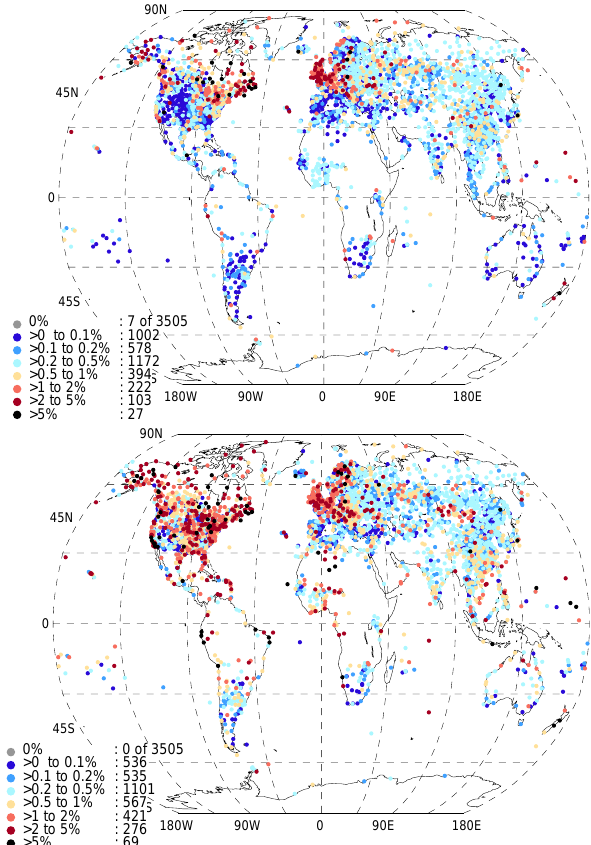
Fig. 2. Percentage of hourly observations removed for each HadISDH station during the HadISD quality control procedure for (top) temperature and (bottom) dew point